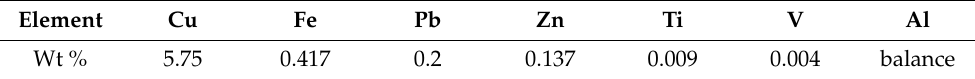
Table 2. Chemical composition of the AA2011 aluminum alloy used in this work (in Wt. %). Element Cu Fe Pb Wt %